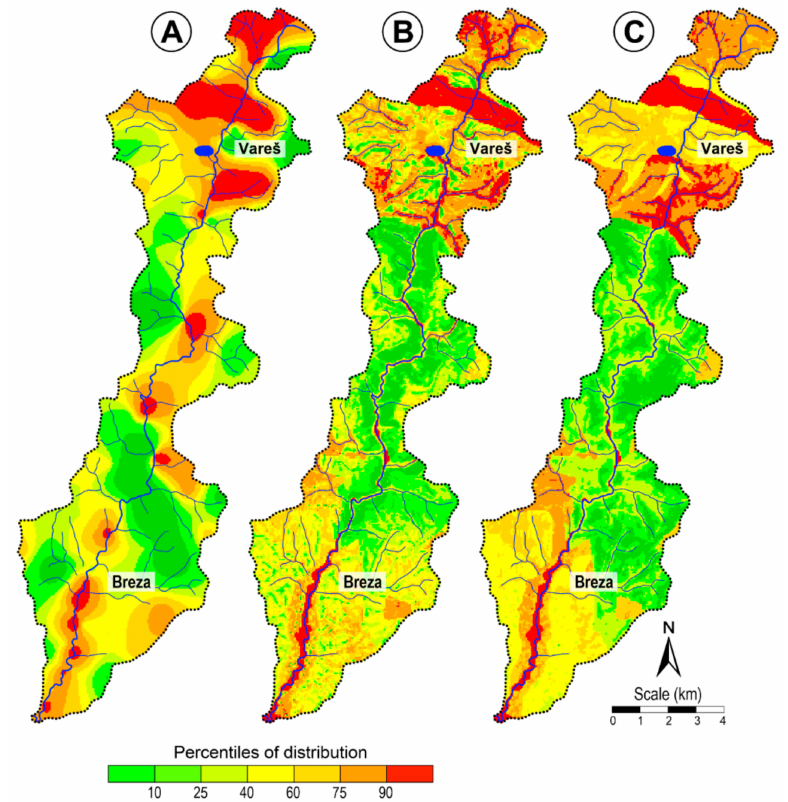
Figure 6. Spatial distribution of Titanium using di ff erent predicting methods: ( A )—Kriging; ( B )—Multiple polynomial regression (MPR); ( C )—Artificial neural network—Multilayer perceptron